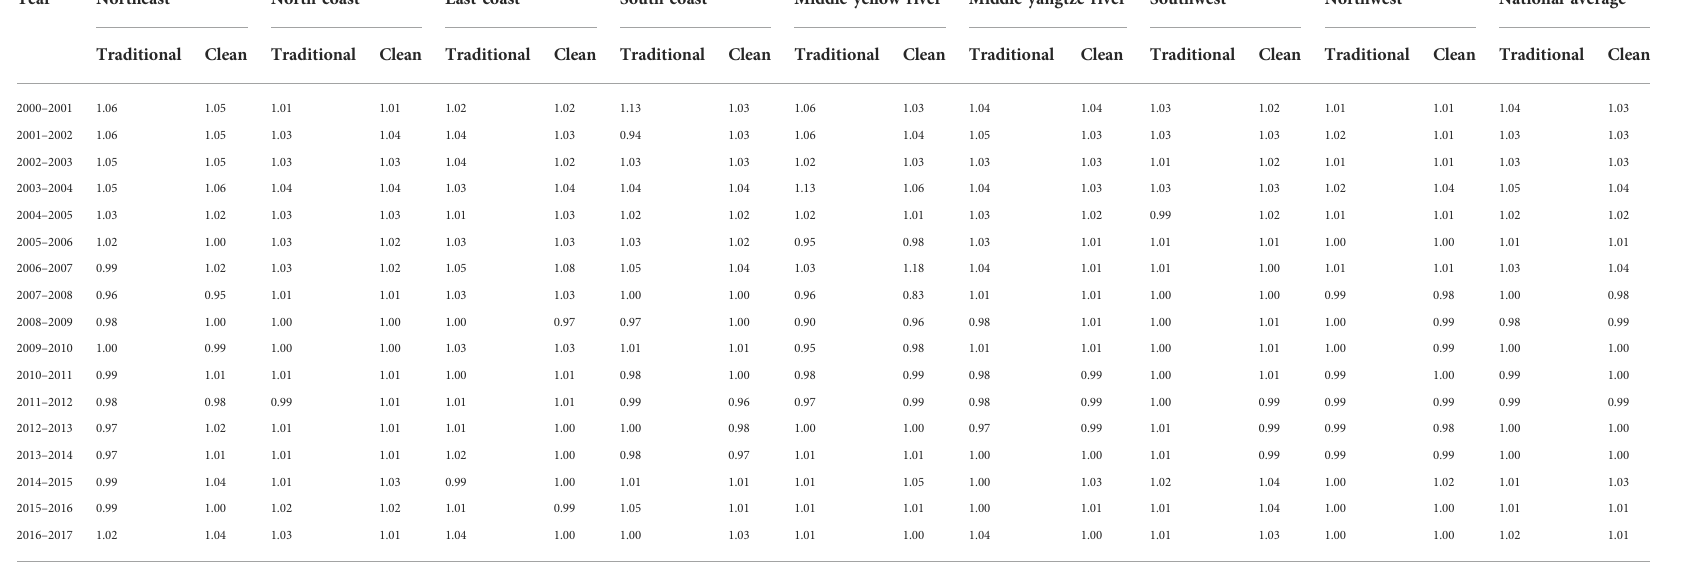
TABLE 2 Change rate of China ’ s fossil energy ef fi ciency and clean energy ef fi ciency. Year Northeast North coast East coast South coast Middle yellow river Middle yangtze river Southwest Northwest National